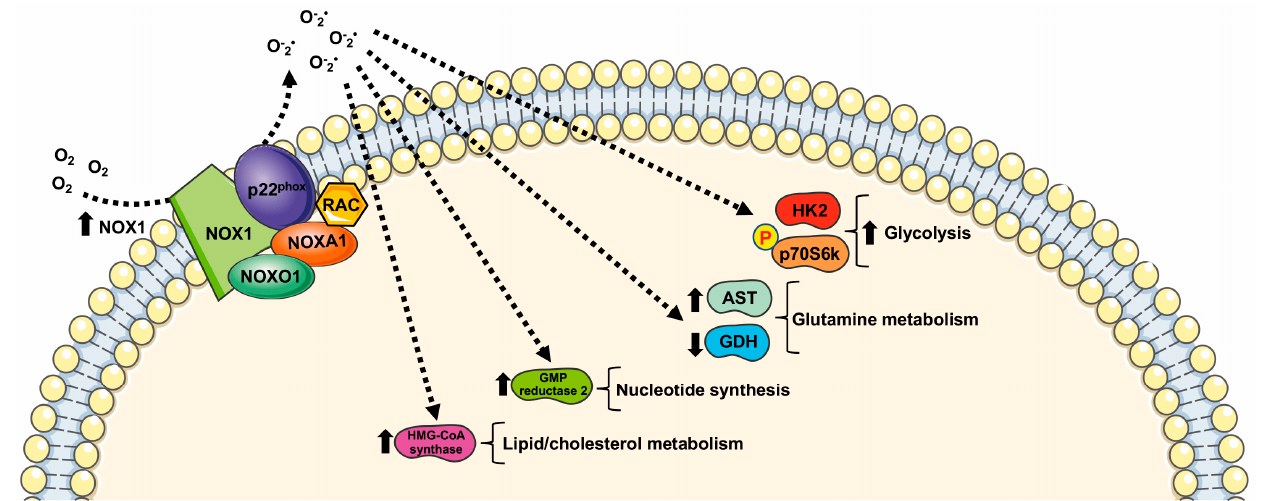
Figure 1. Metabolic pathways supported by NOX1 expression and NOX1-related ROS generation.